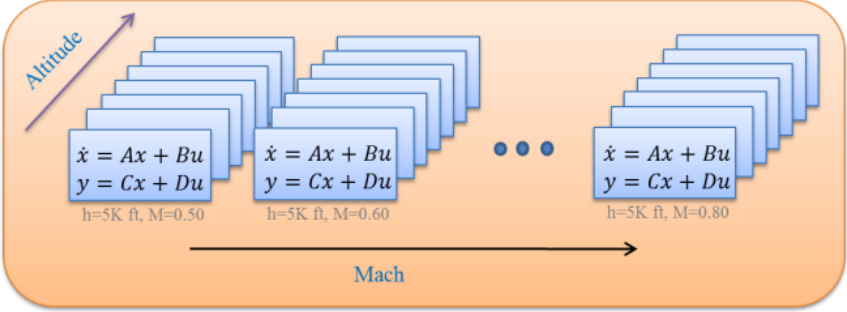
Figure 14. Linear parameter-varying (LPV) models defined in a rectangular